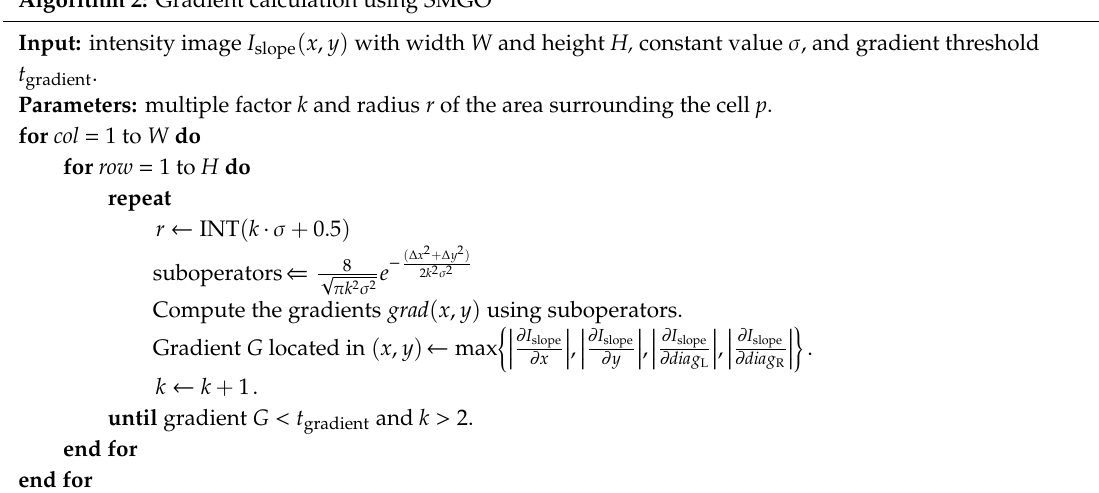
Algorithm 2: Gradient calculation using